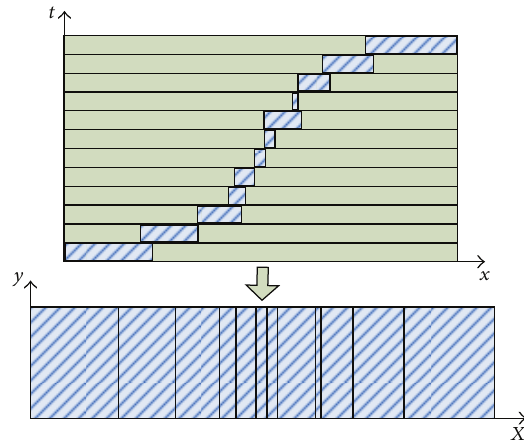
Figure 2: The principle for dynamic scene